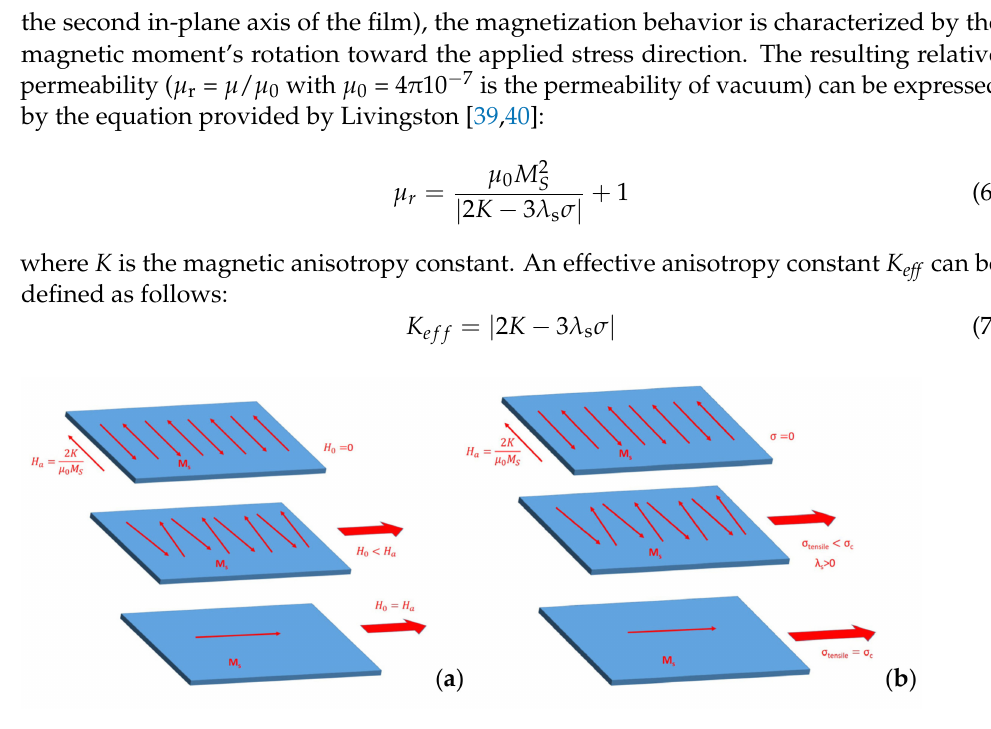
Figure 17. Magnetic behavior of ribbon with transverse magnetic domain with the application of a magnetic field ( a ) and a tensile stress (with λ s > 0) ( b